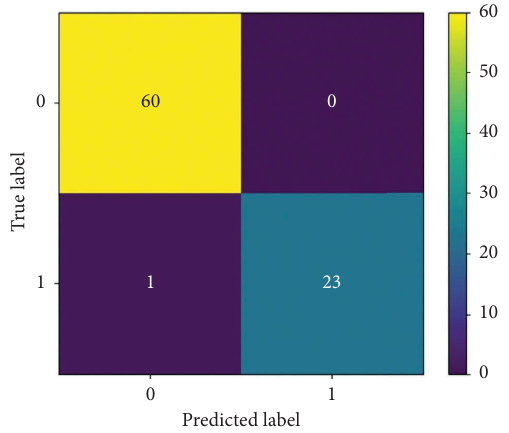
Figure 14: Support vector machine classifcation confusion matrix.